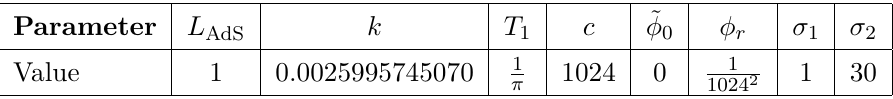
Table 2. The numerical values of the various parameters that are used to produce the plots in figures 14, 16 and 20. The value of T 0 was varied to realize the three reconstructing scenarios described in section 4.2. Notice that this set of parameters is carefully chosen to satisfy eq. (C.17) with T 0 = 459 512 π